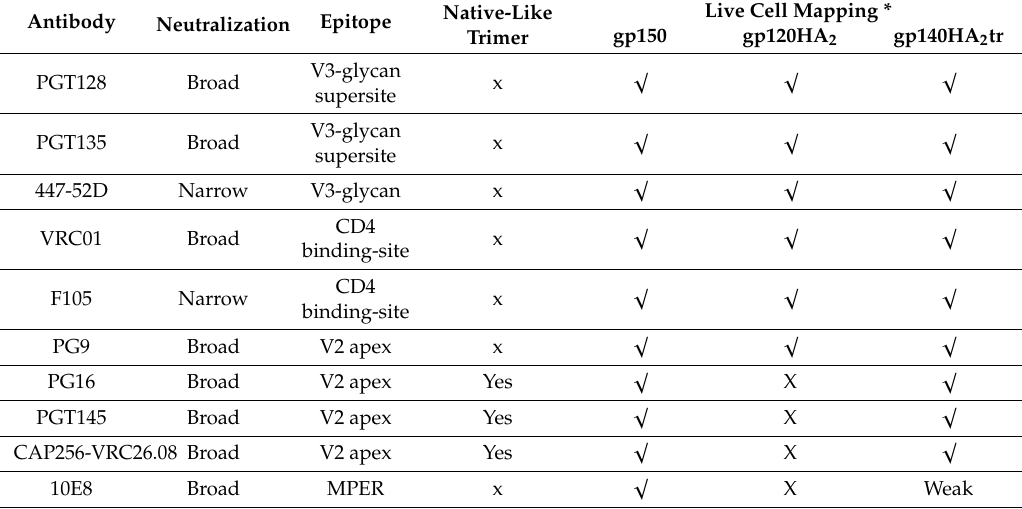
Figure 4. Di ff erential binding of MAbs to gp150, gp120HA 2 , and gp140HA 2 tr. FACS-based cell surface staining of HEK293T cells, transfected with DNA vaccines expressing gp150, gp120HA 2 , and gp140HA 2 tr, with bNAbs and non-NAbs F105 and 447-52D. VRC26.08 = CAP256-VRC26.08. Table 1. Live-cell staining of the envelope (Env) and Env chimeras, expressed on the surface of cells, with monoclonal antibodies